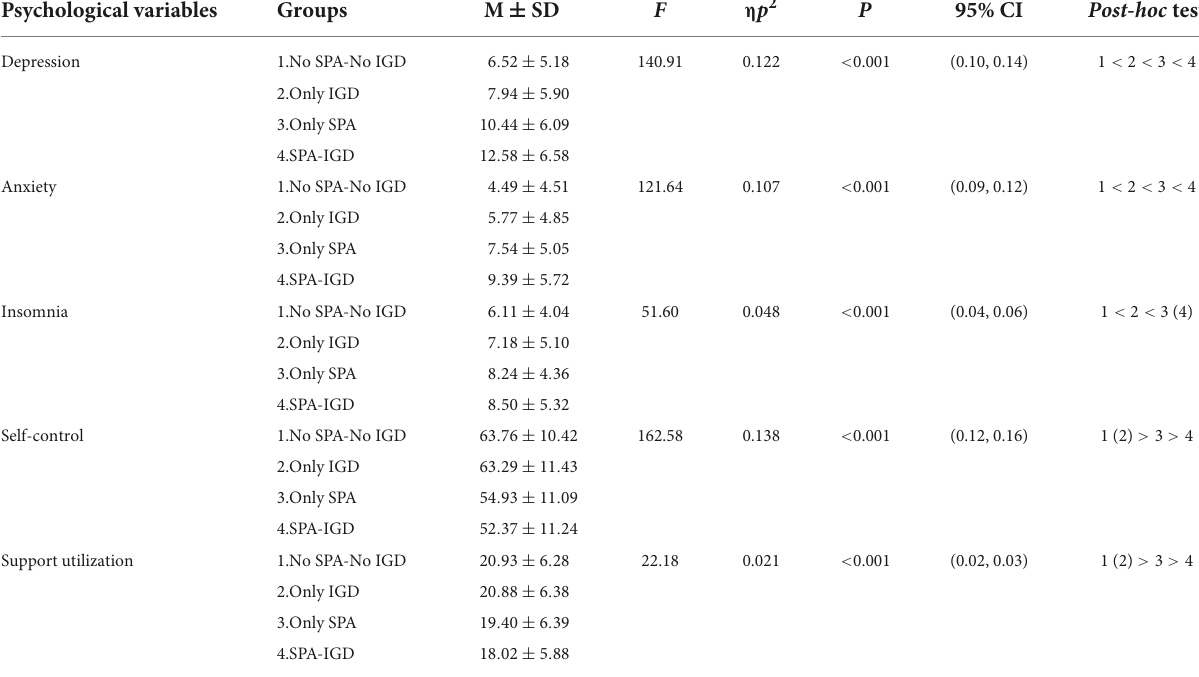
TABLE 2 Differences in psychological variables among the four groups ( n = 3,049).